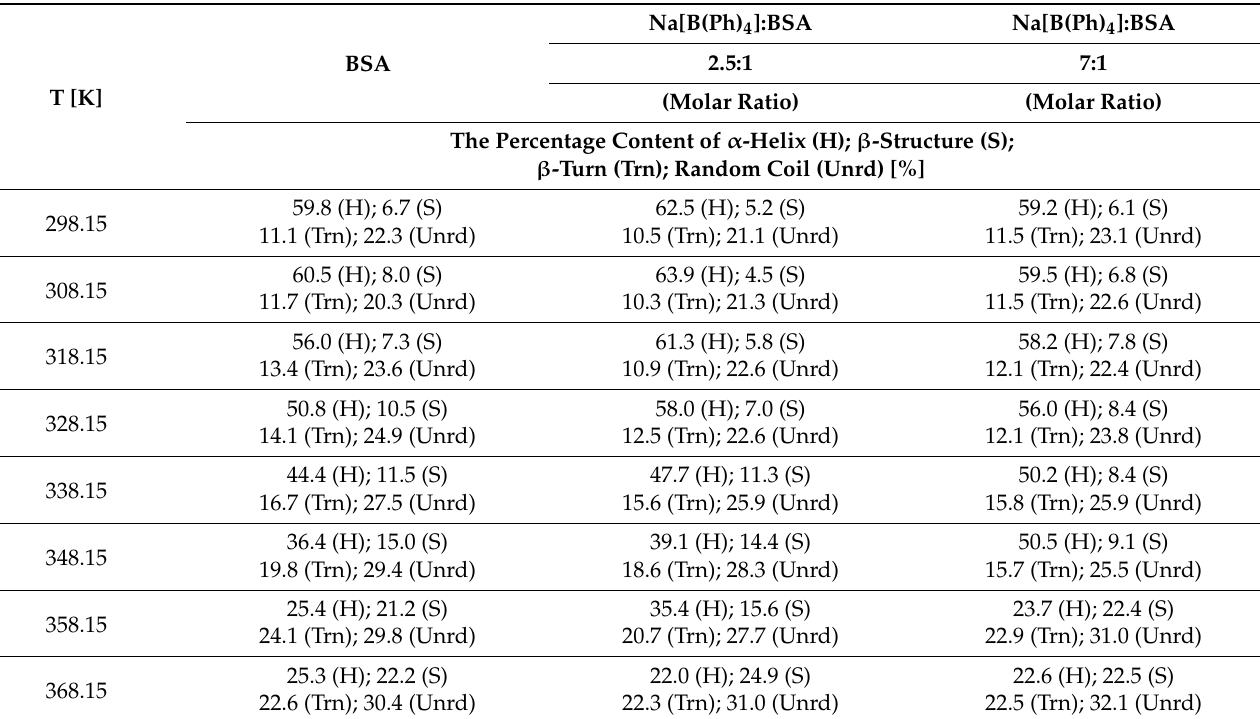
Figure 10. CD spectra of the Na[B(Ph) 4 ]/BSA mixture (Na[B(Ph) 4 ]:BSA = 7:1 molar ratio) in 10 mM Caco buffer at pH 7, in the temperature range 298.15–368.15 K. The concentration of BSA was maintained at 0.0015 mM. Table 3. The secondary structure content (%) of BSA at different Na[B(Ph) 4 ]:BSA molar ratios in 10 mM Caco buffer at pH 7 in the temperature range 298.15–368.15 K, revealed from CD measurements.